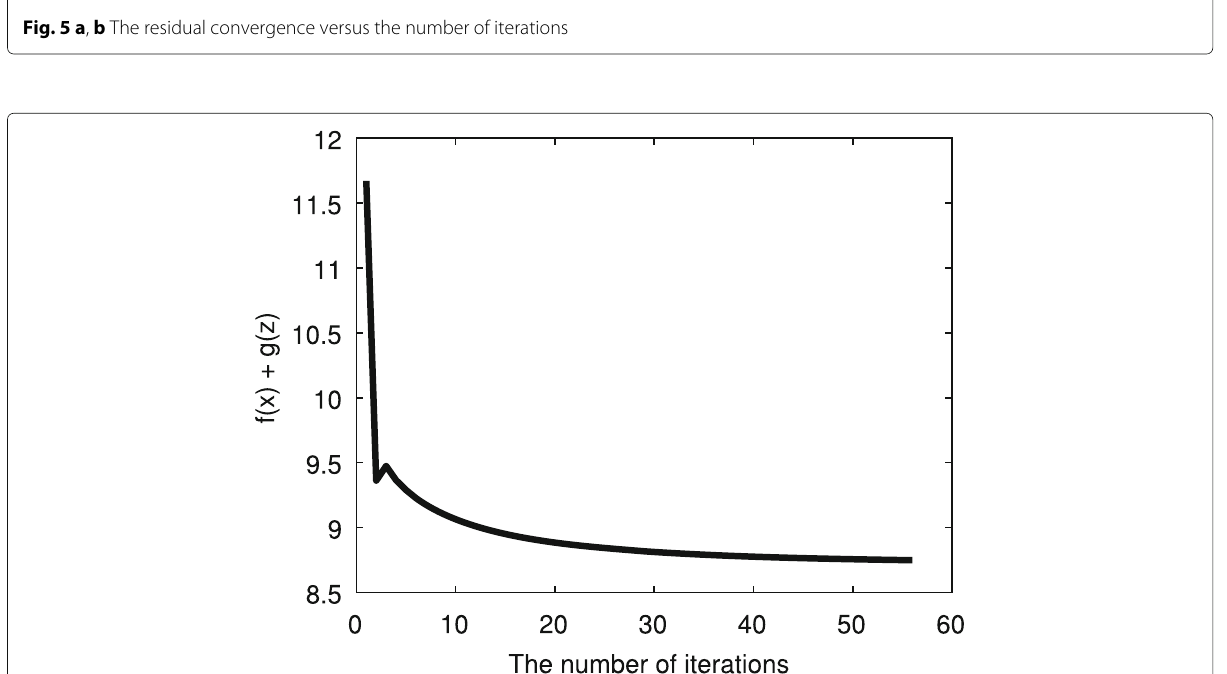
Fig. 6 The objective convergence versus the number of